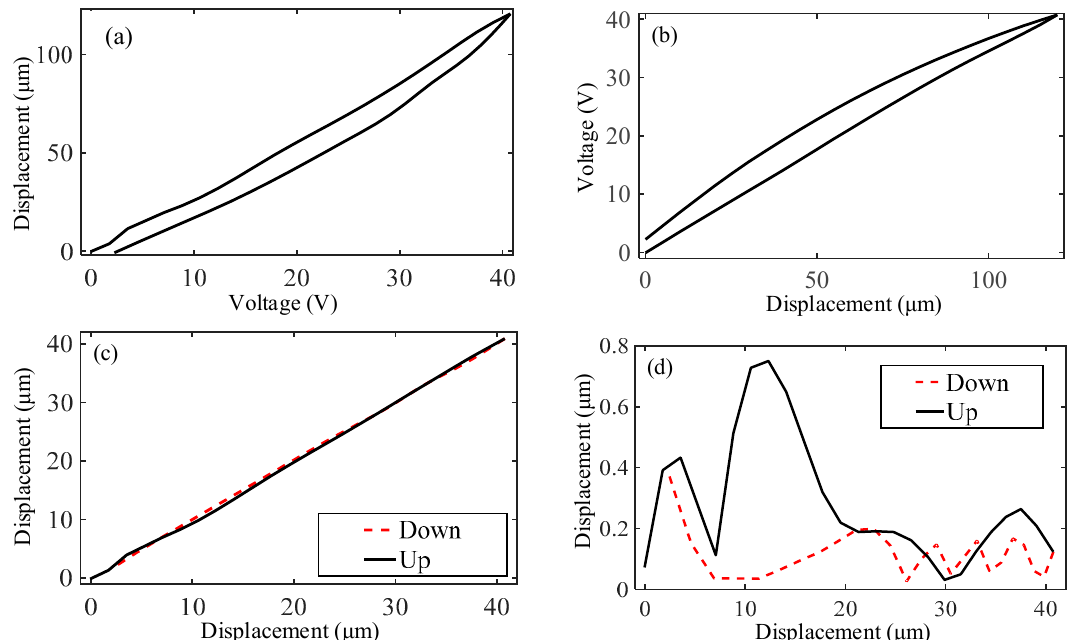
Figure 9. Schematic diagram of the inverse Preisach model compensation: ( a ) the hysteresis loop, ( b ) the inverse hysteresis loop, ( c ) the compensated output, and ( d ) the compensated output error.